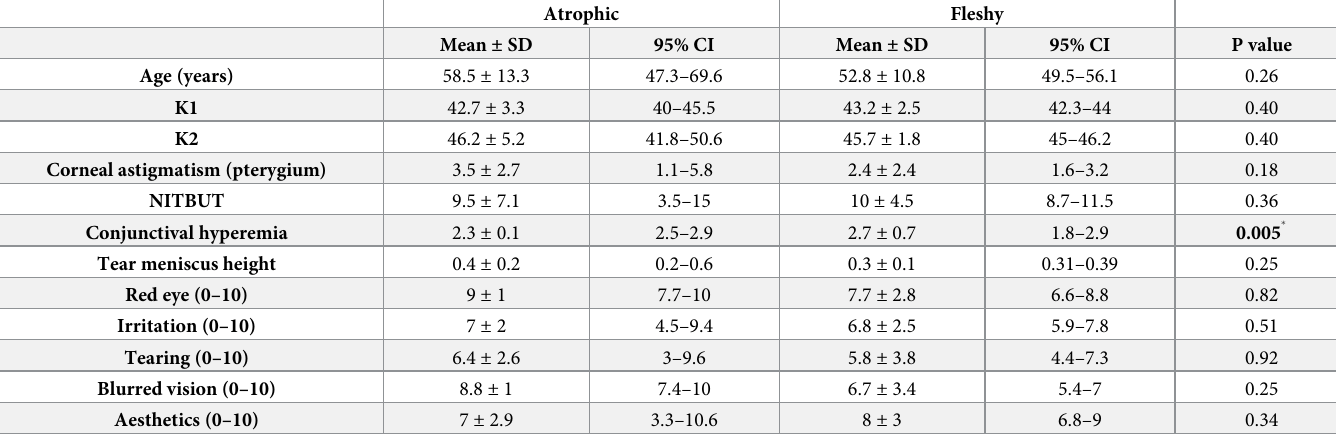
Table 3. Data distribution according to the pterygium clinical presentation (atrophic and fleshy).